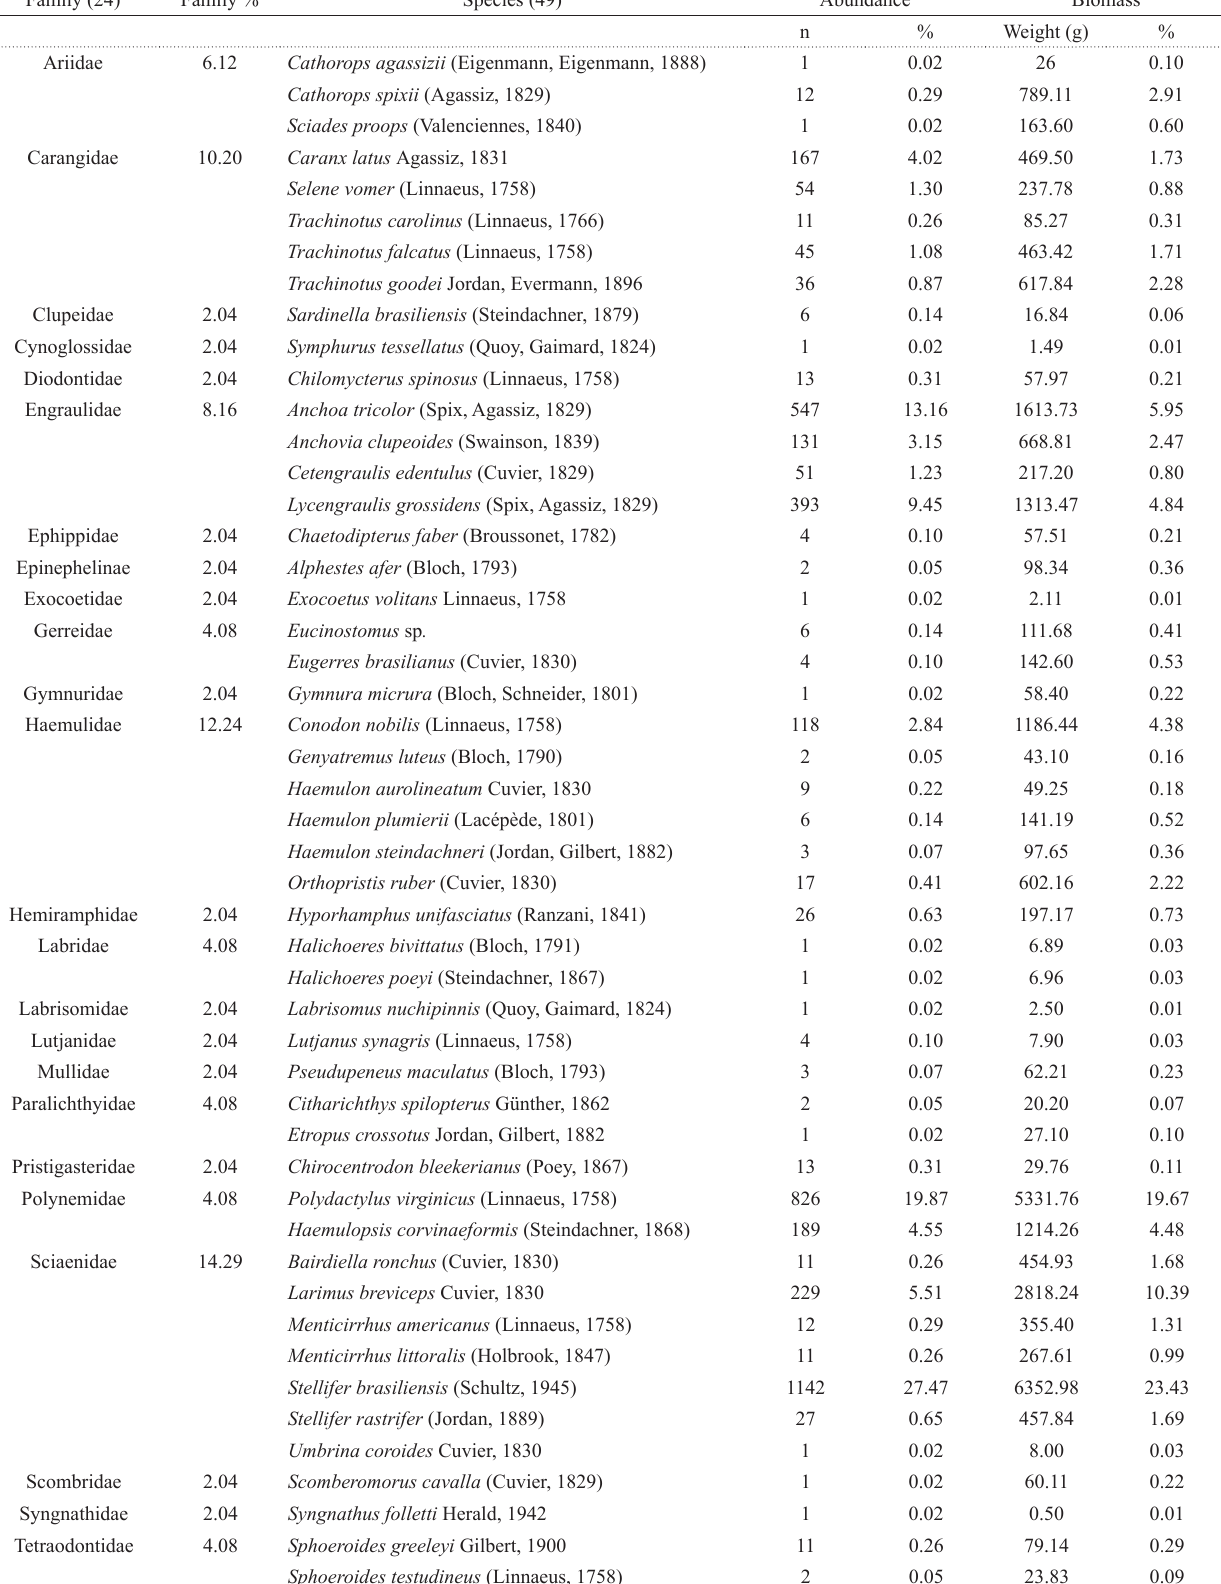
Tab. 1. Abundance (n), biomass (g), and relative percentages of the specimens from the surf zone of Miramar Beach, in Cabedelo, Paraíba, northeast